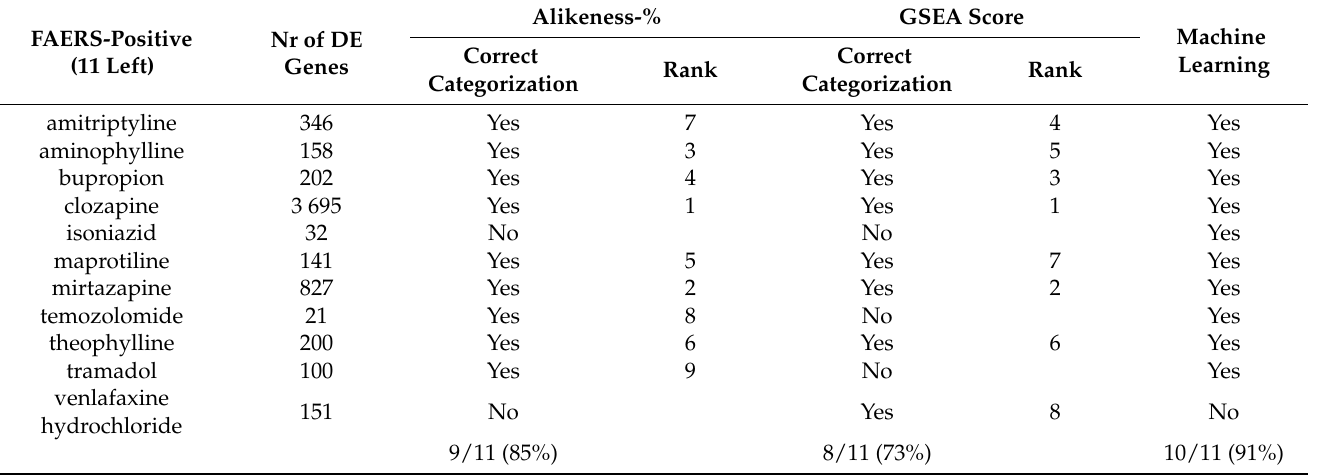
Table 7. Summary of correct categorization of FAERS-positive compounds by different analysis approaches. Diphenhydramine and paroxetine were excluded from the summary due to the low number of differentially expressed (DE) genes. The higher the rank, the greater the alikeness-% or GSEA